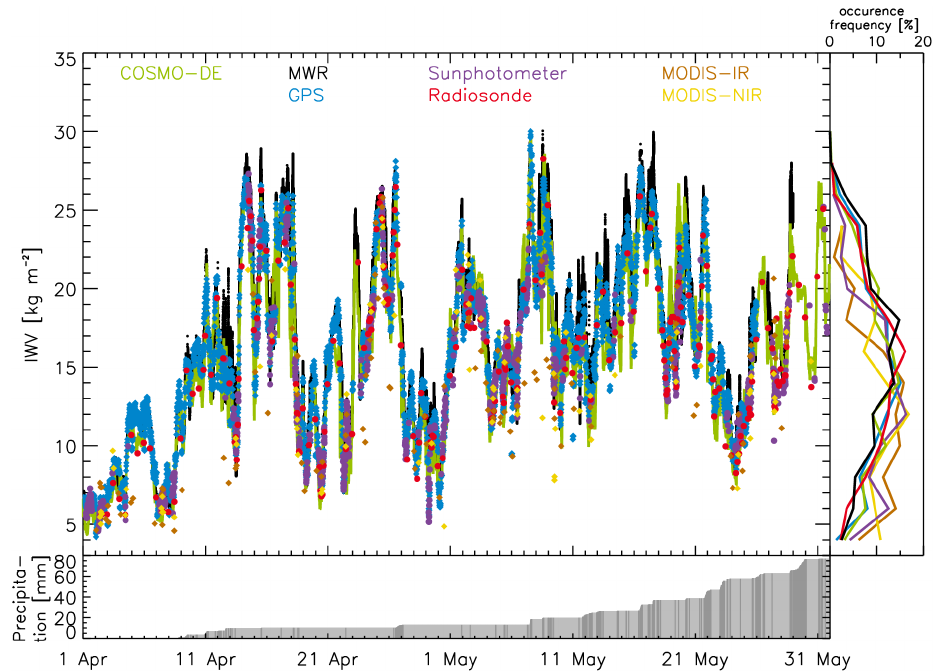
Figure 5. Time series of IWV during HOPE. Displayed are: MWR (black), GPS (blue), sun photometer (purple), radiosoundings (red), MODIS-IR (orange), MODIS-NIR (yellow), and COSMO-DE (light green). The frequency of occurrence of IWV are displayed in the right panel with corresponding colours. Accumulated precipitation is shaded in grey in the lower panel; dark grey bars indicate the time when precipitation